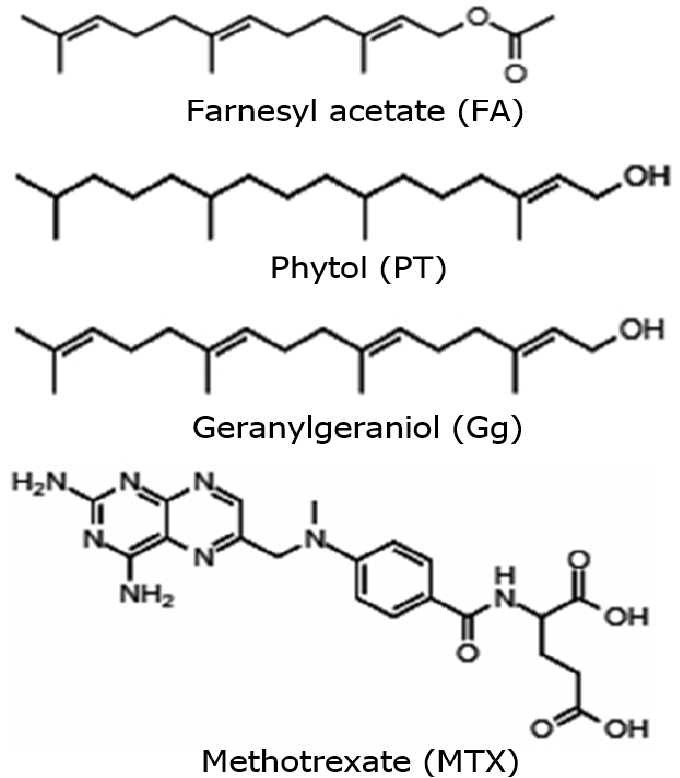
Figure 1. Structures of geranylgeraniol, phytol, and farnesyl acetate obtained of petroleum ether extract from A. macroprophyllata leaves (PEAm) and methotrexate. Table 2. GC-MS, retention times, and percent in area of geranylgeraniol (Gg), phytol (PT), and farnesyl acetate (FA) identified from petroleum ether extract from A. macroprophyllata leaves.